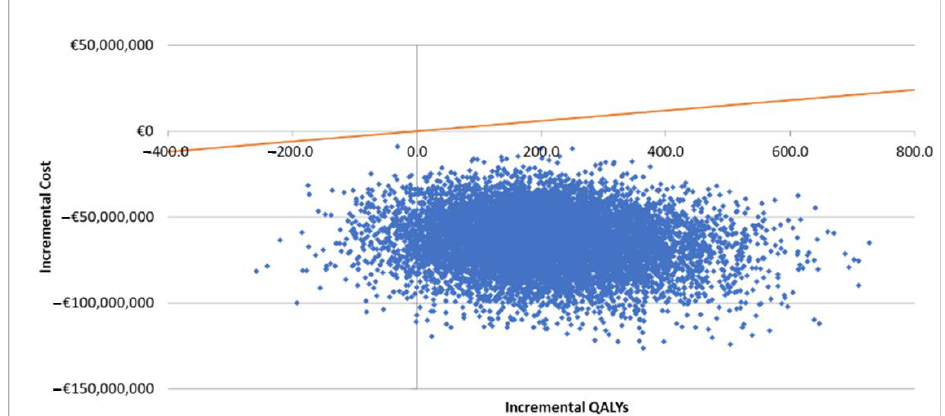
Figure 4. Cost-effectiveness plane for aQIV vs. HD-QIV. Abbreviation: QALY = quality-adjusted life year. Orange line represents the willingness-to-pay threshold in Spain of EUR 25,000 per QALY [55,56].